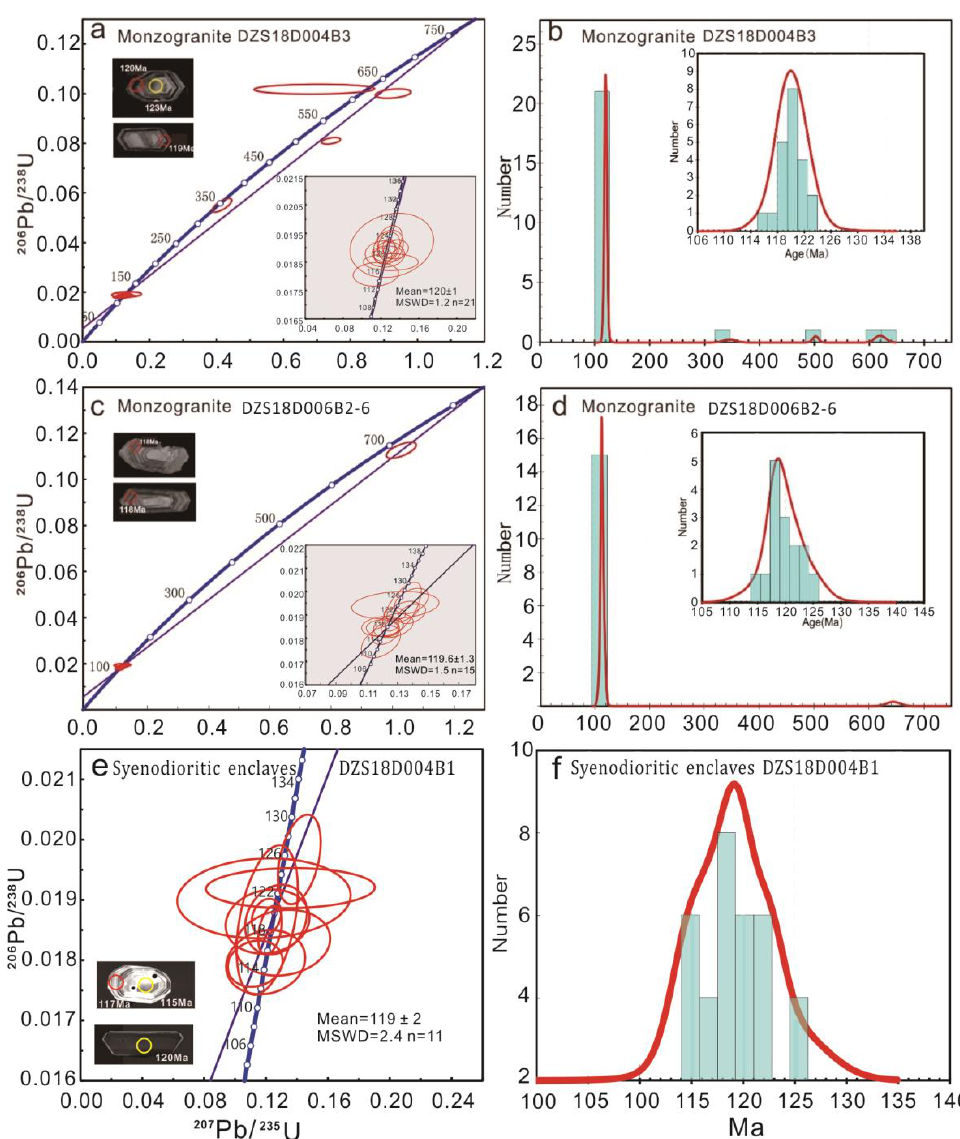
Figure 4. Zircon LA-ICP-MS U-Pb concordia age diagrams and histograms of Dazeshan monzogranites ( a – d ) and their enclaves ( e , f ). The insets show the typical zircon CL images with U-Pb apparent